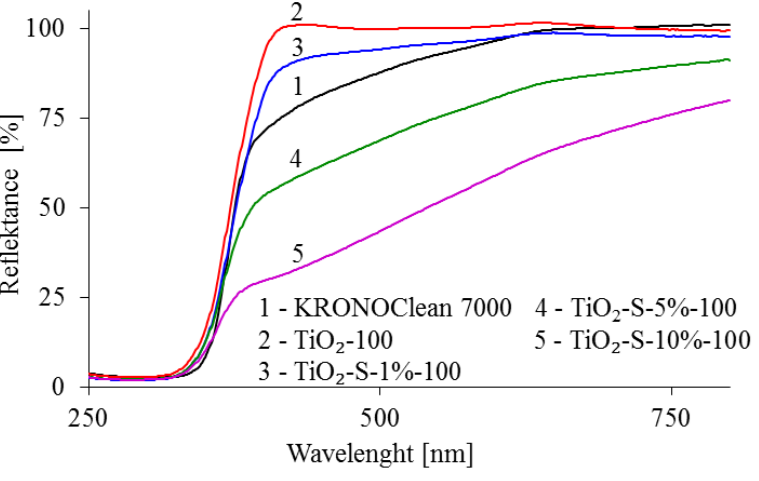
Figure 4. UV – Vis/DR spectra of tested samples. Figure 4. UV–Vis/DR spectra of tested